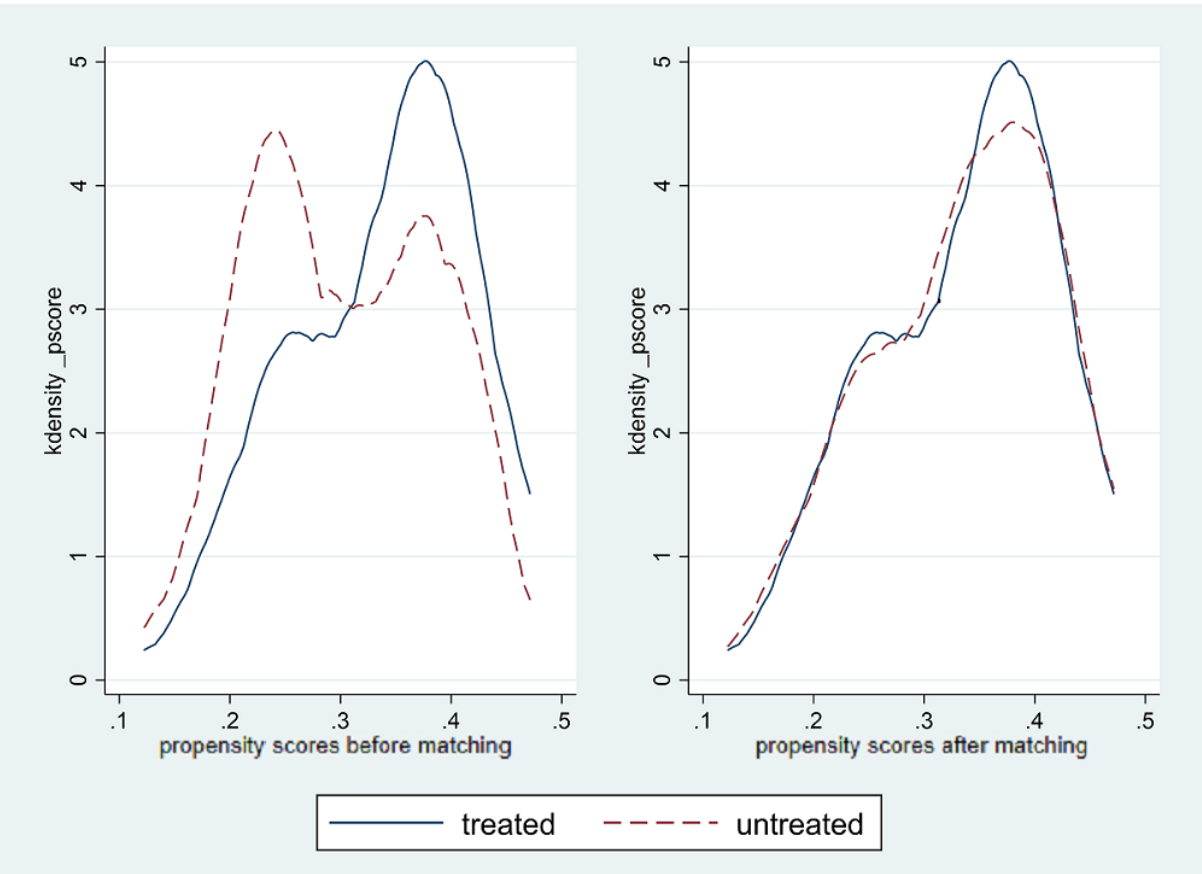
Figure 2. Density plots in health information sharing behavior. Treated sample comprised daily users of internet banking, and the rest of the users were included in the untreated